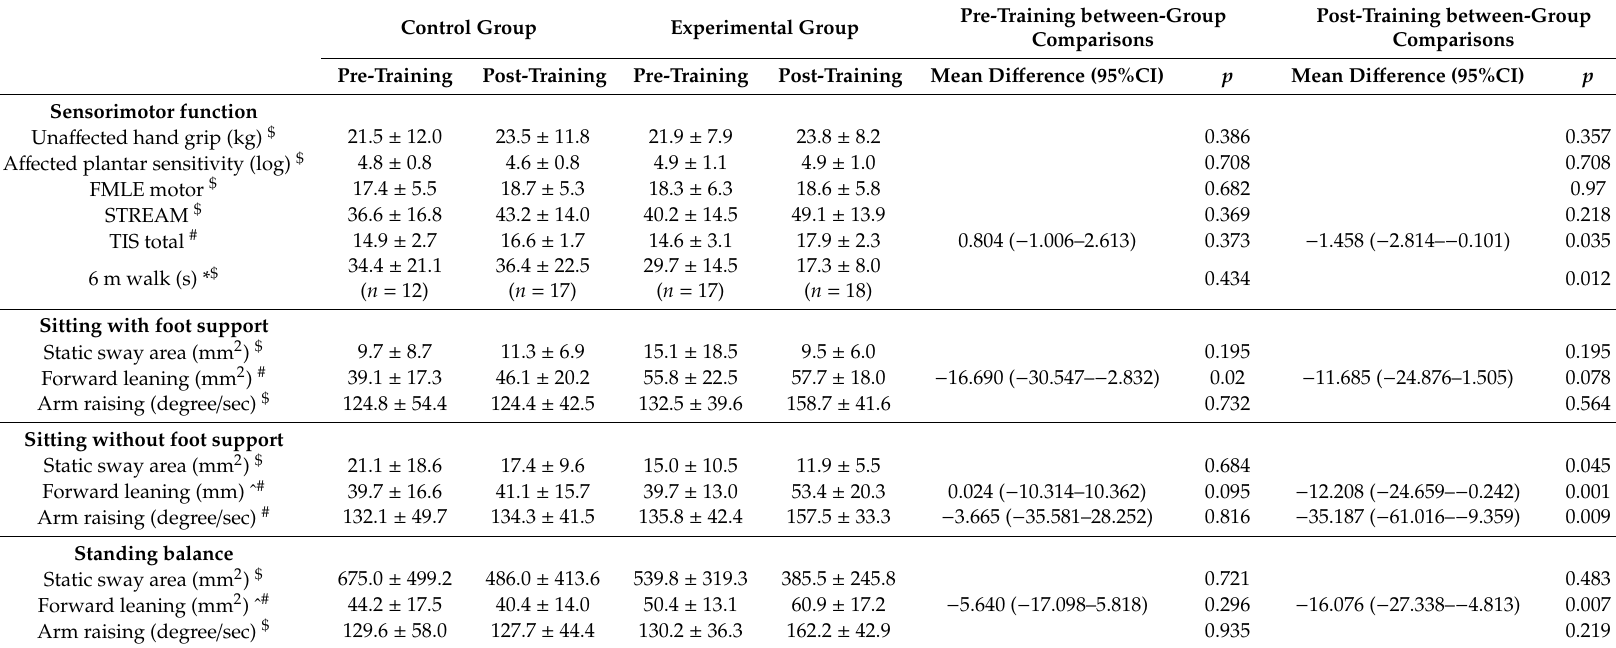
Table 3. Sensorimotor function, and balance, and walking performance pre- and